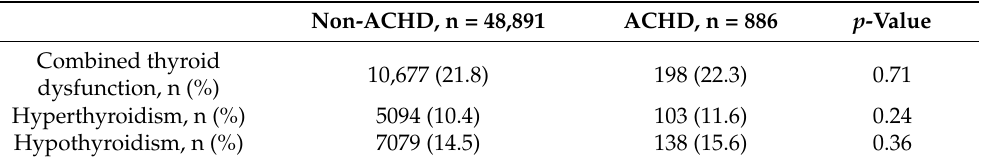
Table 2. Occurrence of thyroid dysfunction stratified by presence and absence of congenital heart disease (ACHD = adult congenital heart